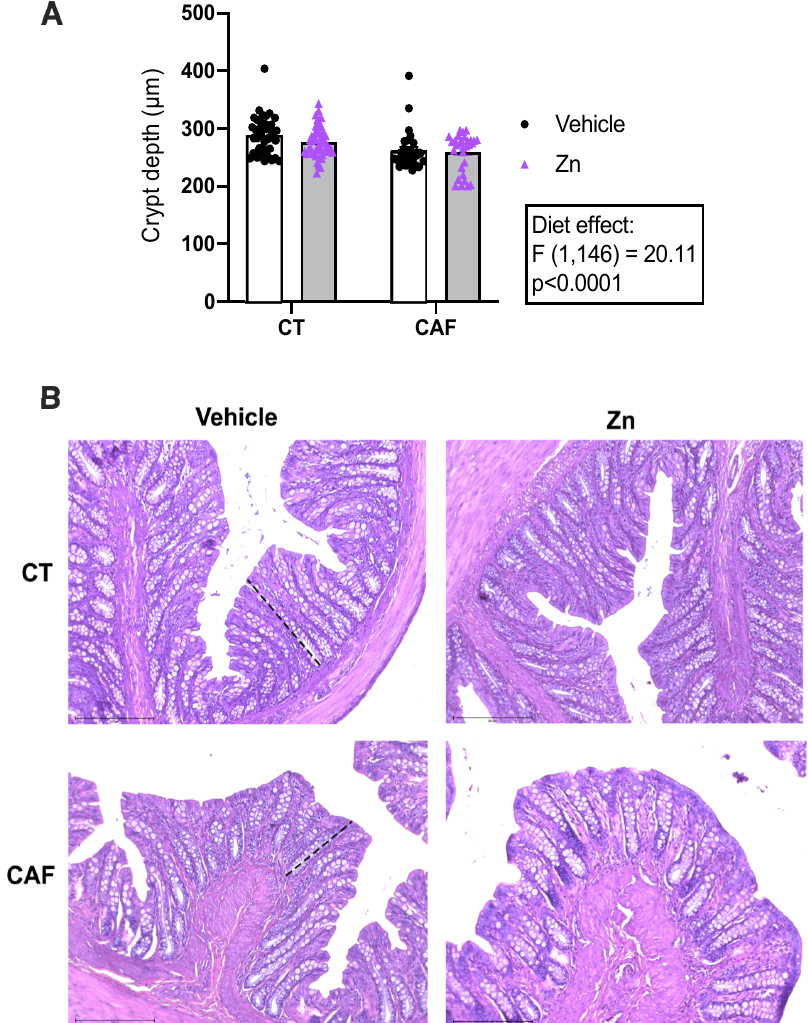
Figure 1. Crypt depth measurement in the proximal portion of the colon of control (CT) and cafeteria diet (CAF)-fed rats. ( A ) Crypt depth was reduced following CAF. ( B ) Representative images of each group of the colon stained with hematoxylin and eosin. The dashed lines indicate crypt length. Scale bar: 200 μ m. The text box indicates significant differences shown by two-way ANOVA regarding the effects of the diet (CT and CT + Zn vs. CAF and CAF + Zn) and Zn treatment (CT and CAF vs. CT + Zn and CAF + Zn). n = 3–5 animals/group, 10 measurements per animal.